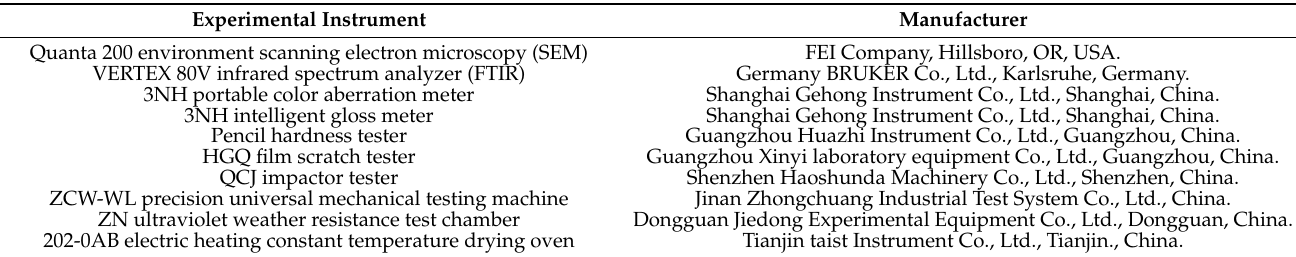
Table 4. Experimental test